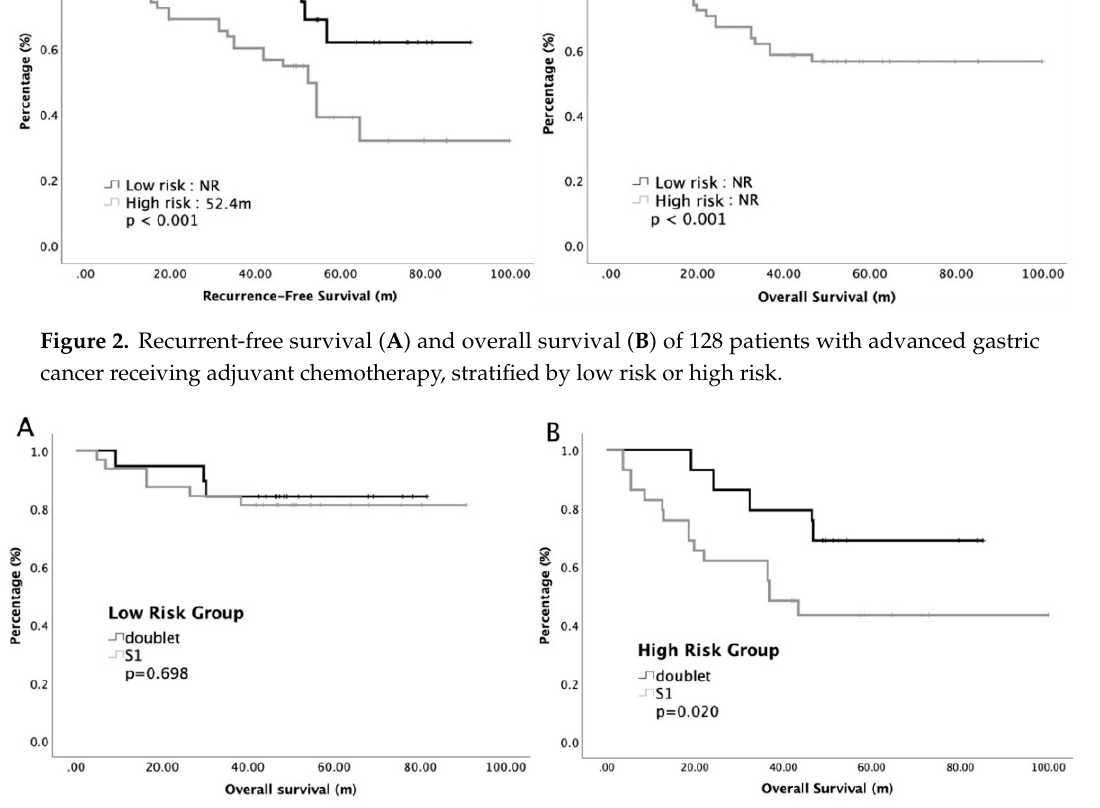
Figure 3. Overall survival of advanced gastric cancer patients with low risk or high risk, stratified by adjuvant chemotherapy regimens.